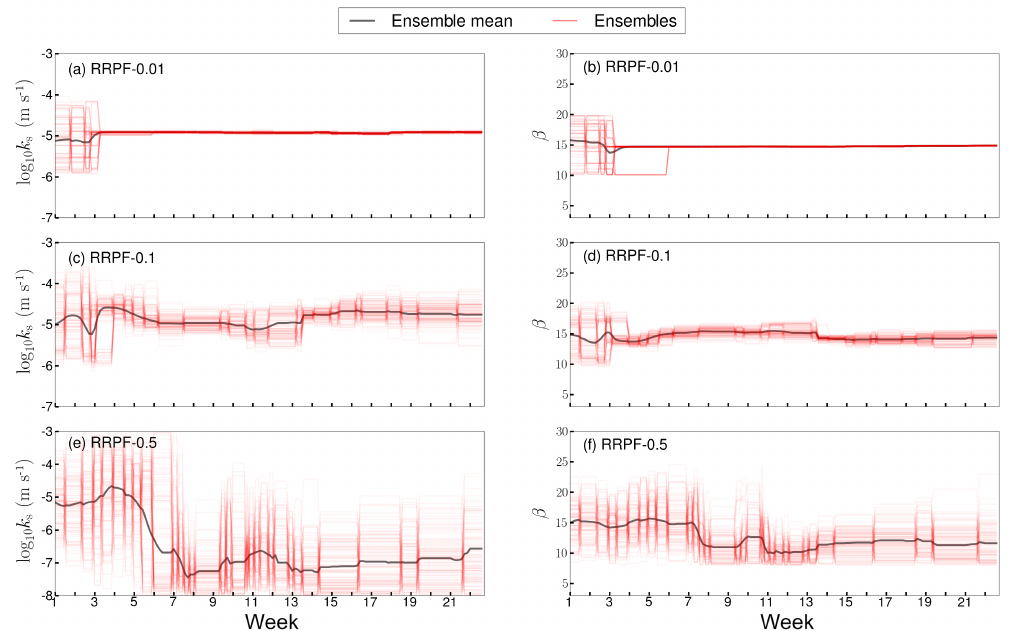
Figure 8. Sampled trajectories of the N = 100 ensemble members (solid red lines) of the saturated hydraulic conductivity (log 10 k s in ms − 1 ) at 50cm depth (a, c, e) and parameter β (b, d, f) of VIC-3L during the 5-month assimilation period of weeks 1 to 22 using (a–b) RRPF-0.01,